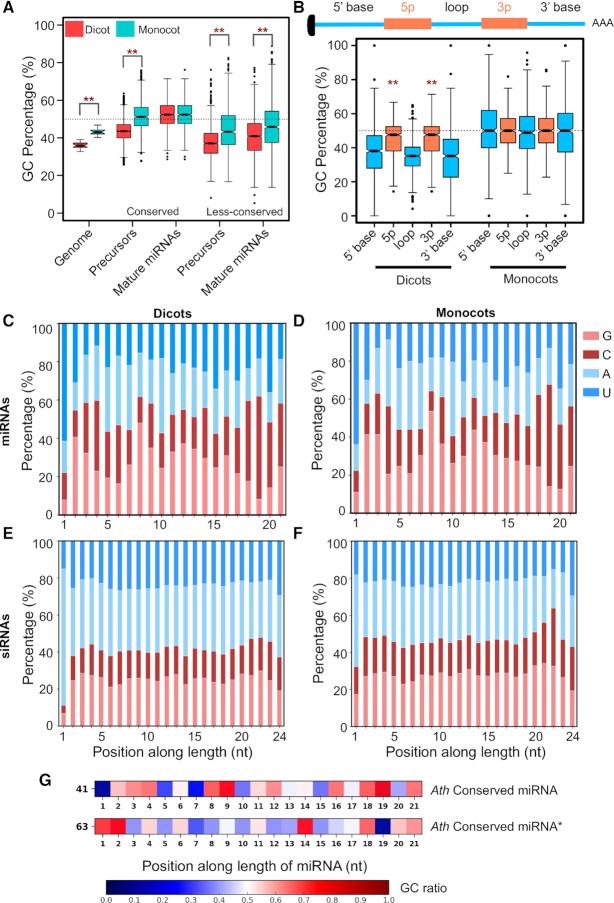
Plant mature miRNAs have unique GC content and signature. (A) Boxplots representing GC content of Pre- and mature miRNA regions of conserved and less-conserved miRNAs (dicot genome, 20; monocot genome, 14; dicot conserved precursor, 2335; miRNAs, 2722; monocot conserved precursor, 691; miRNA, 1005; dicot less-conserved precursor, 2471; miRNA, 2862; monocot less-conserved precursor, 925; miRNA, 1191). Boxplots display interquartile range (box), whiskers (extending 1.5 times the interquartile range), median (thick line), and outliers (dot). The notch around median represents a 95% confidence interval. Asterisk labels significant difference (**P < 0.001, Mann–Whitney U Test) between dicot and monocot GC contents. (B) GC content in different segments of Pre-miRNAs from monocots and dicots (dicots, 769; monocots, 557). The asterisks indicate significant difference (**P < 0.001, Mann–Whitney U Test) between mature miRNA GC and precursor GC of dicots. (C–F) Position-specific percentage nucleotide abundance, along the length of conserved unique dicot miRNAs (672), (C); conserved unique monocot miRNAs (263), (D); 24-nt sequences from dicots (546375), (E); 24-nt sequences from monocots (265546), (F). (G) Matrix showing flexible GC signature across miRNAs (5′ to 3′). Non-redundant conserved 21-nt miRNAs from A. thaliana (41), and miRNA stars of conserved miRNAs from A. thaliana (63) were used. The colour represents the GC ratio at each position.